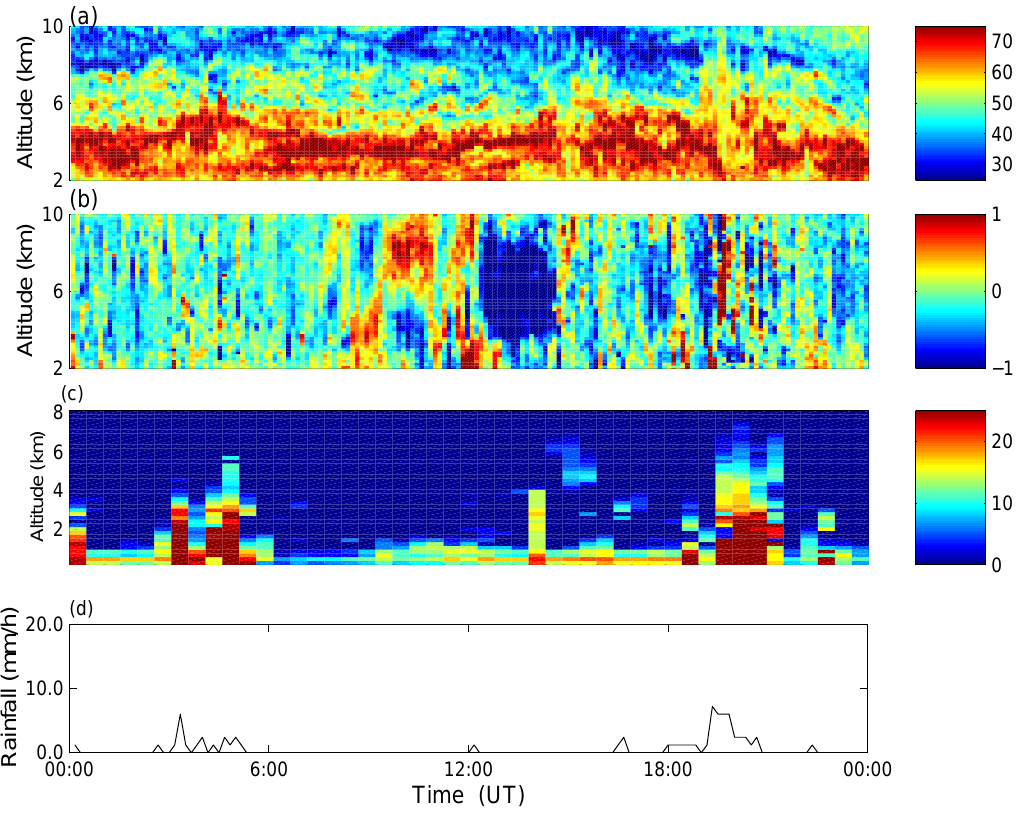
Fig. 4. Time-height contour plots of ( a ) vertical signal power (dB), ( b ) vertical velocity (m s − 1 ) observed by the VHF radar, ( c ) the vertical signal-to-noise ratio measured by a co-located UHF wind profiler (dB) and ( d ) the variation of surface rainfall observed by a tipping bucket rain gauge on 5 October